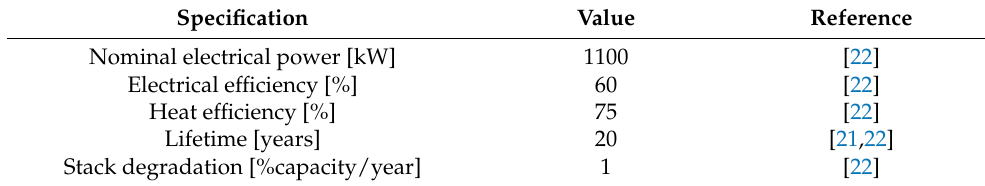
Table 2. Technical specifications of the SOFC unit.